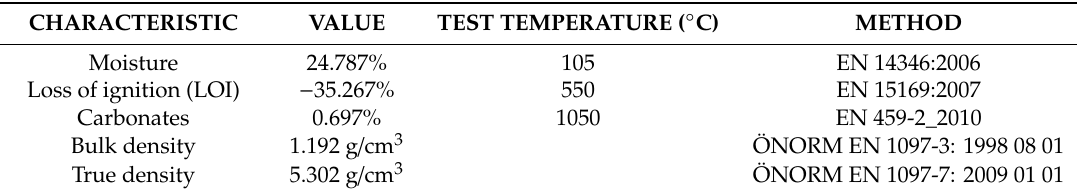
Table 2. Physical analysis of grinding sludge samples.